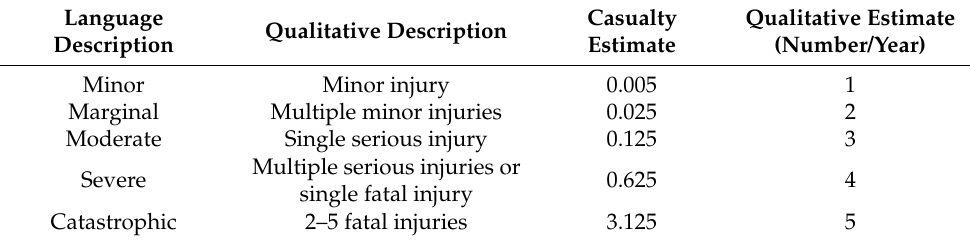
Table 6. Safety behavior risk consequence rating standard of the train operation department.